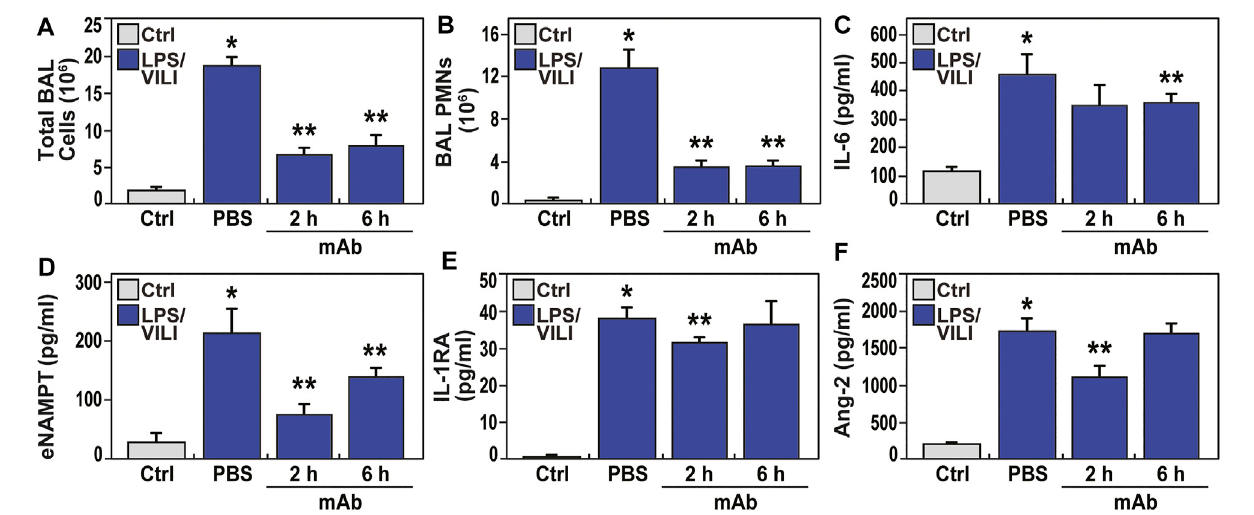
FIGURE 2 | The eNAMPT-neutralizing ALT-100 mAb attenuates BAL alveolitis and plasma ARDS biomarker increases in the LPS/VILI porcine model. (A,B) ConsistentwithH&E fi ndings( Figure1 ),LPSVILI-exposedminipigsexhibitsigni fi cantincreasesinBALtotalin fl ammatorycellcountsandBALPMNswhicharemarkedly attenuated in pigs receiving the ALT-100 mAb (0.4 mg/kg), delivered IV either 2 h or 6 h after initiation of LPS/VILI (* p < 0.05 vs. control, ** p < 0.05 vs. untreated LPS/ VILI). (C – F) Plasma levels of IL-6, eNAMPT, IL-1RA and angiopoetin-2 (Ang-2) measured by MesoScale Discovery platform at time 0 and at 12 h were markedly increased in LPS/VILI-challenged pigs. The levels of each biomarker were reduced in pigs receiving the ALT-100 mAb at 2 and 6 h after initiation of LPS/VILI. ALT-100 mAb-mediated reductions in eNAMPT and Ang-2 plasma levels were signi fi cantly greater in 2 h when compared to 6 h treated animals (* p < 0.05 vs. control, ** p < 0.05 vs. untreated